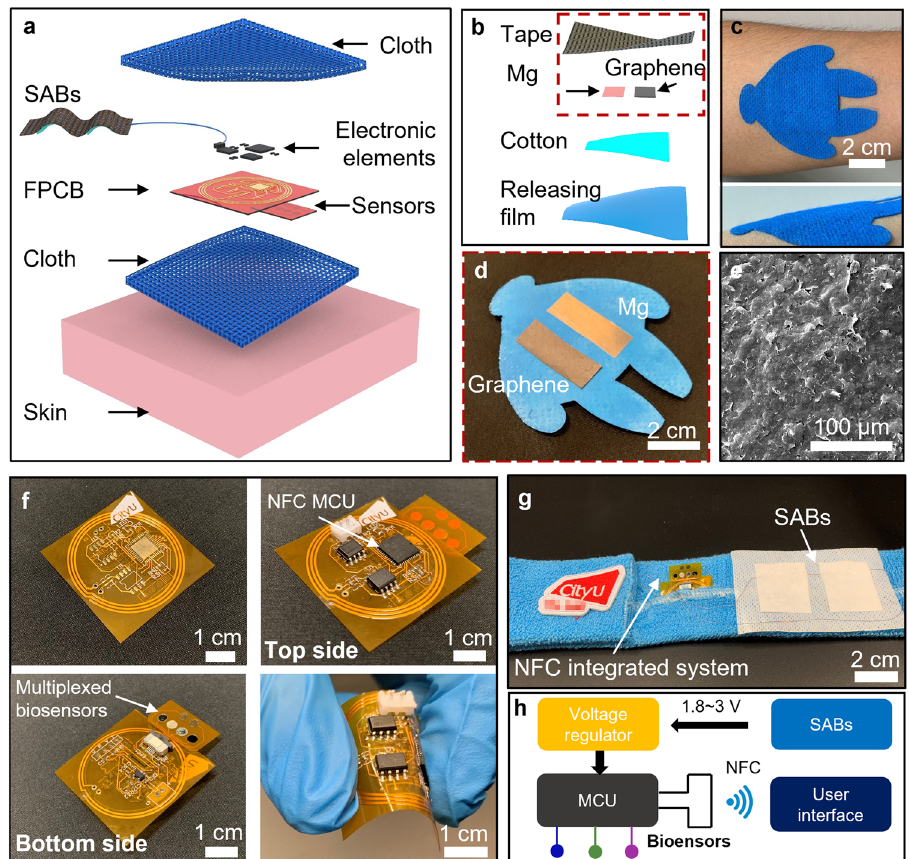
Fig. 1 SABs powered microelectronics system for multiplexed wireless sensing. a Schematic illustrations of the skin integrated electronic system. b Schematic illustrations of the ultra-thin SAB. c Optical images of the SAB mounted on human forearm and the enlarged details of side views with the Cartoon shape of a Baymax. d Optical images of the electrodes for the SAB. e SEM image of graphene-coated absorbent paper. f Optical images of the microelectronics system integrated with multiplexed biosensor patch and fl exible circuit. g Optical images of the microelectronics system embedded into a head band. h System-level block diagram of the electronic module for the whole